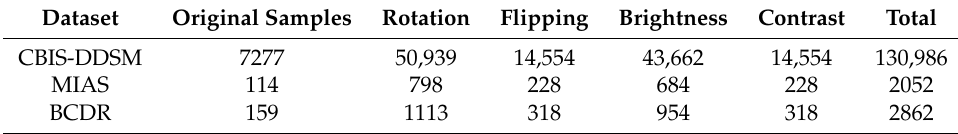
Table 1. The number of samples before and after applying every augmentation method for each dataset.